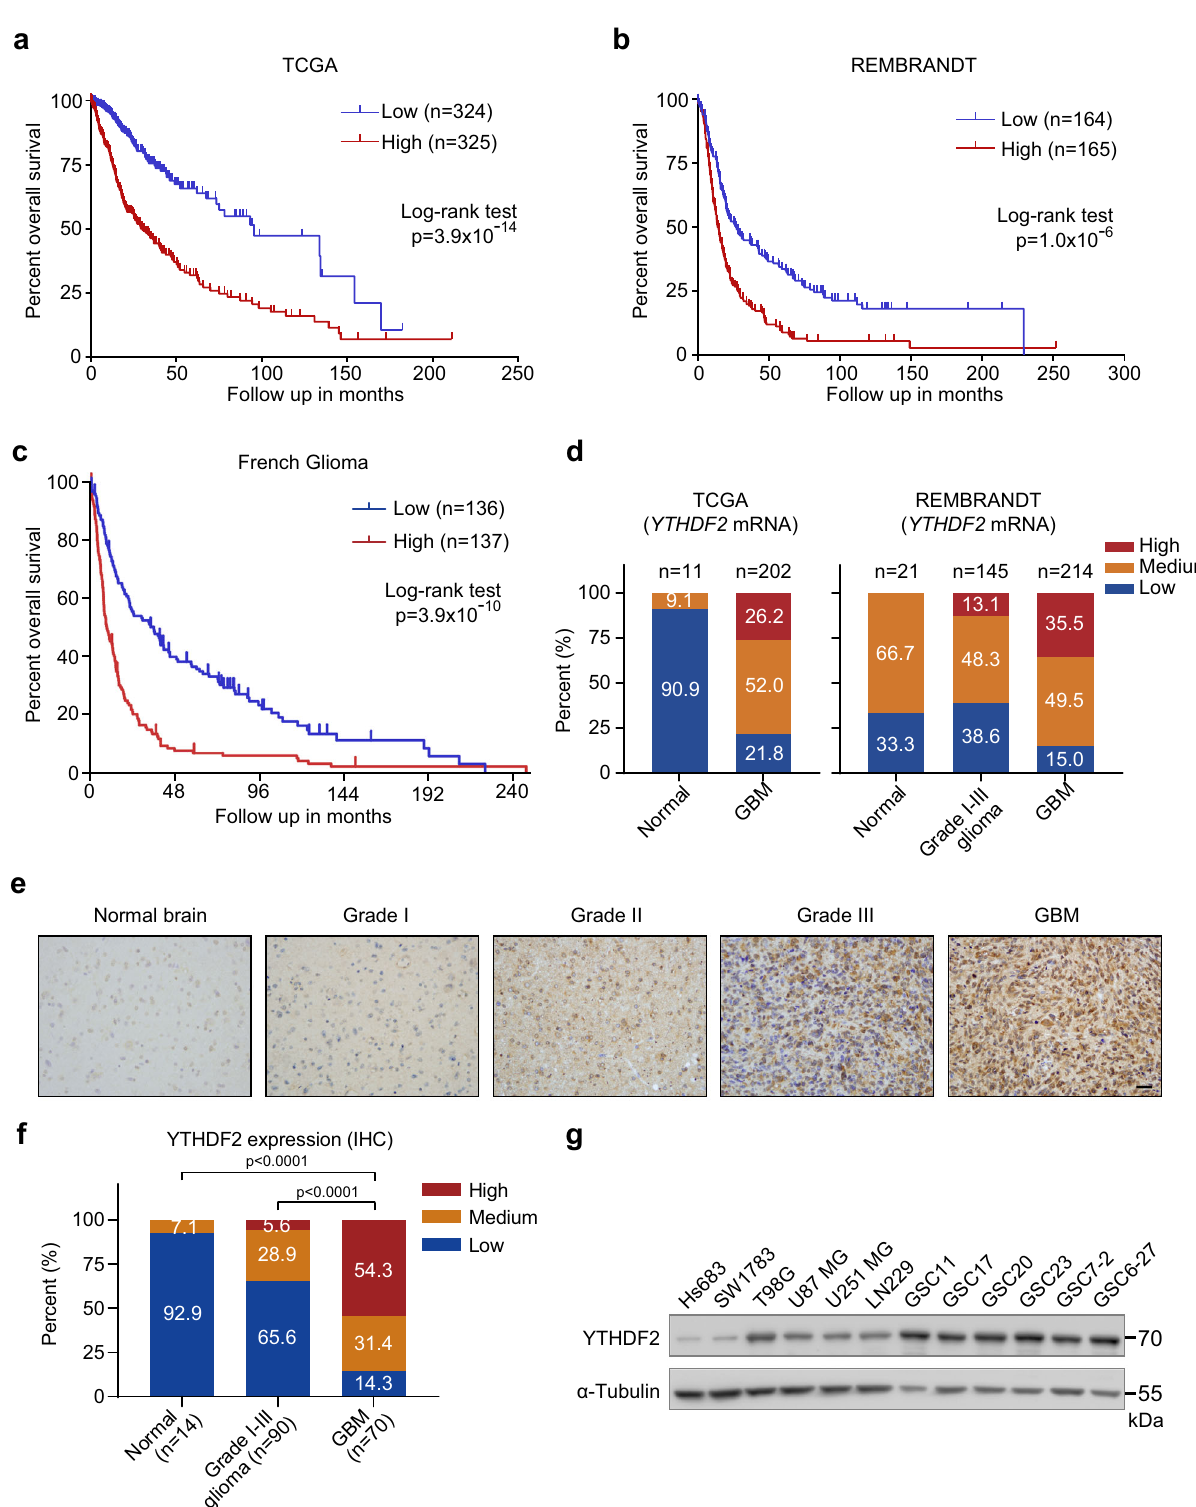
(Fig. 3b, c). Interestingly, EGFR inhibition by ge fi tinib or deple- tion by siRNA reduced the expression of YTHDF2 protein without affecting the mRNA levels (Supplementary Fig. 3b, c), suggesting a post-transcriptional regulation involved in the increase of YTHDF2. Moreover, inhibition of EGFR by ge fi tinib in GSC11 cells accelerated degradation of YTHDF2 protein (Fig. 3d), whereas induction of EGFRvIII expression in LN229/ NATURE COMMUNICATIONS| (2021) 12:177